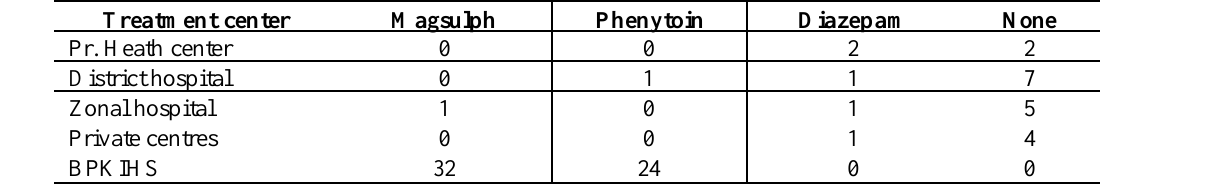
Table VII : Major anticonvulsant used